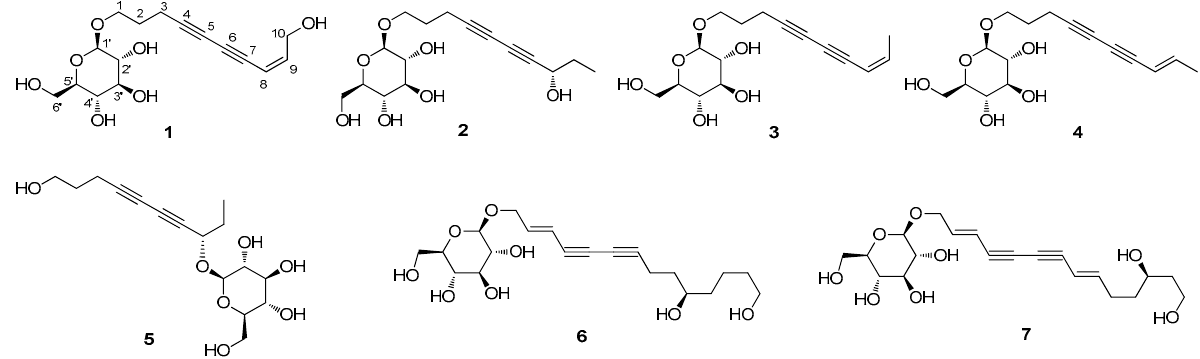
Figure 1. The chemical structures of the isolated compounds 1 – 7 .